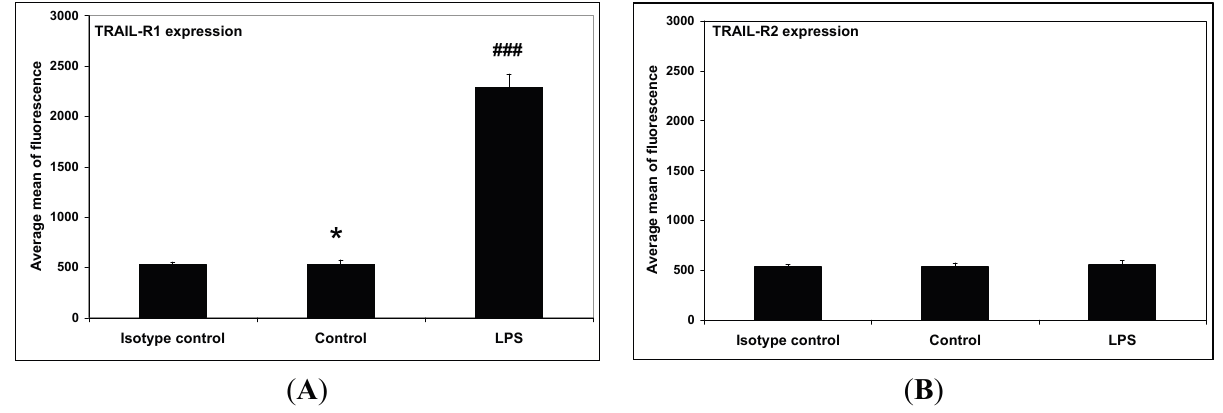
Figure 4. The surface expression of TRAIL-R1 ( A ) and TRAIL-R2 ( B ) on LPS (lipopolysaccharide)-activated macrophages RAW264.7, analyzed using flow cytometry. The values represent mean ± SD of three independent experiments. * p < 0.05 compared to isotype control. ### p < 0.001 compared to control.